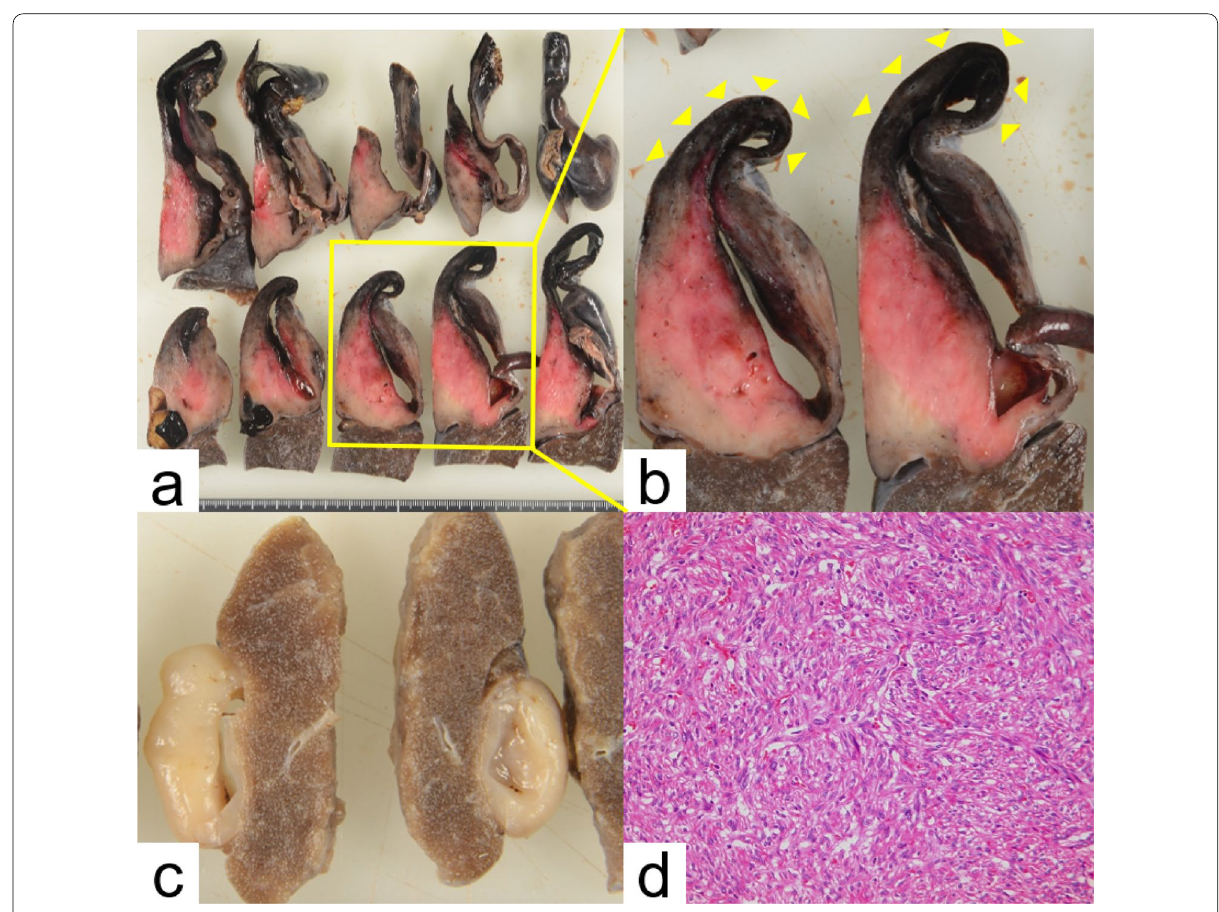
Fig. 3 Pathological findings. a The macroscopic findings of right apical lesion. b The area of enlargement is indicated by the yellow square ( a ). The right upper lobe lesion included minute bleeding in the solid component around the cyst (yellow arrowheads). c Macroscopic findings of the right lateral basal segment lesion revealed no evidence of bleeding. d Microscopic findings revealed tangled spindle-shaped cells with little atypia and no tumor necrosis (original magnification 200) ×